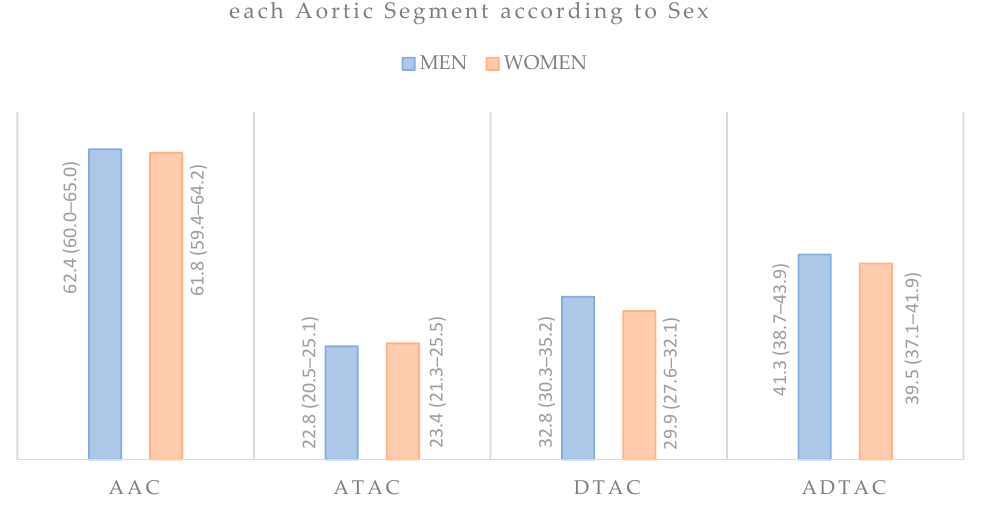
Figure 2. Clustered column graph demonstrating age- and body surface-adjusted prevalences of calcium in men and women in all aortic segments. AAC = aortic arch calcium; ATAC = ascending thoracic aortic calcium; DTAC = descending thoracic aortic calcium; ADTAC = ascending and descending thoracic aortic calcium.